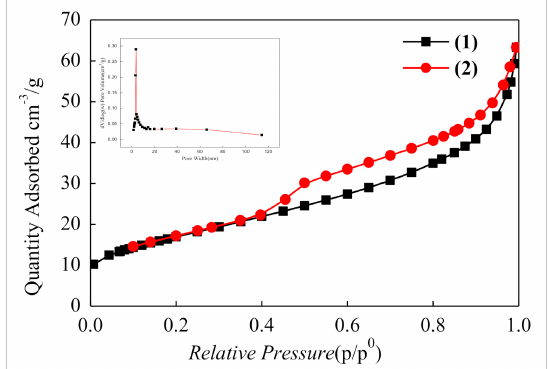
Figure 9. N 2 adsorption–desorption curves and pore diameter distribution of zeolite A synthesized by solid-phase alkali fusion. (cid:4) Adsorption; •